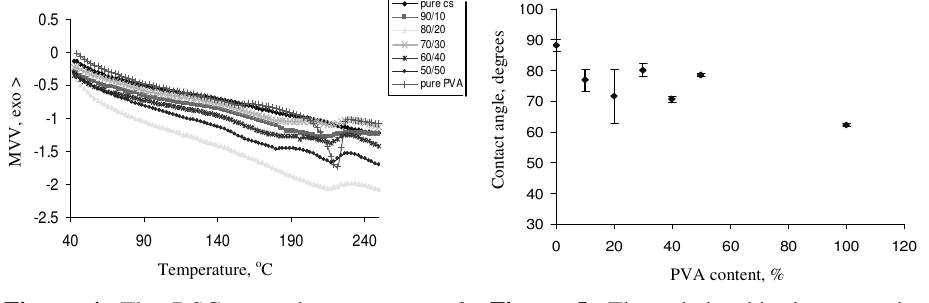
Figure 5. The relationship between the water-contact angle and the PVA content